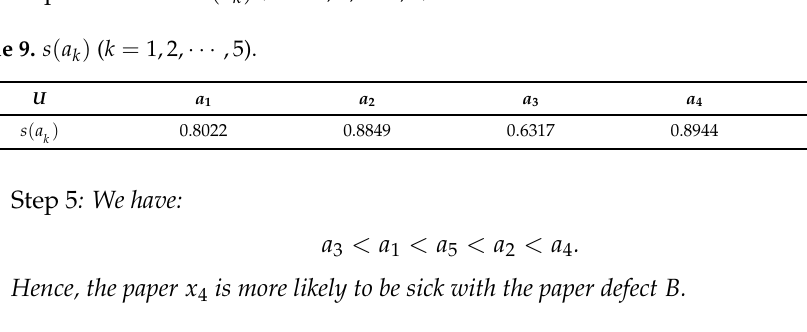
Table 9. s ( a k ) ( k = 1,2,